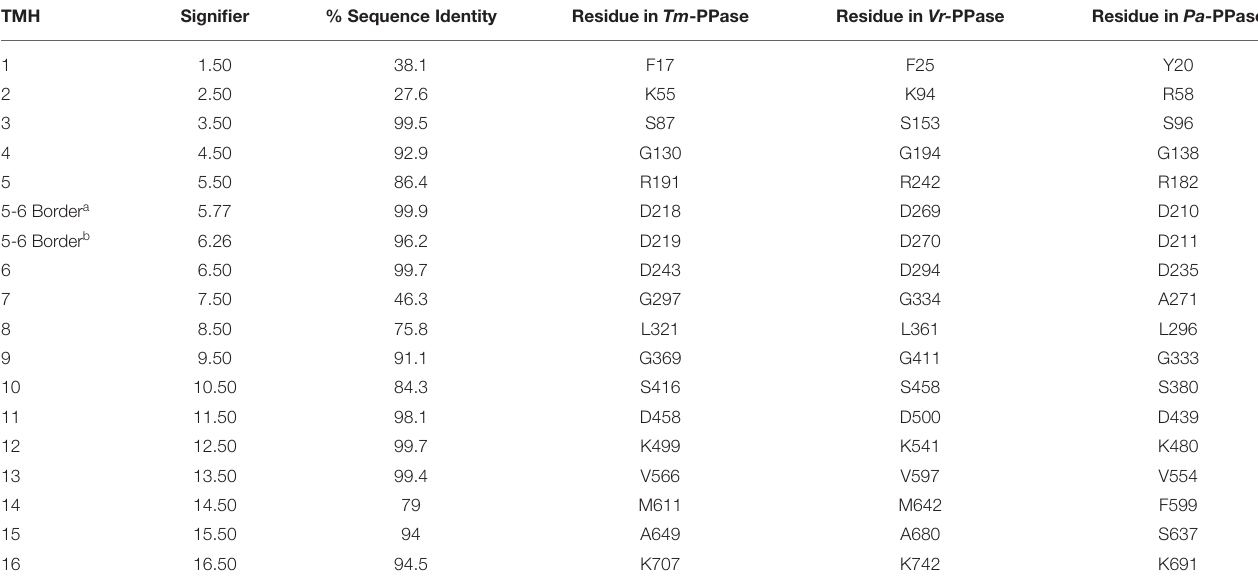
TABLE 3 | Ballesteros and weinstein numbering for